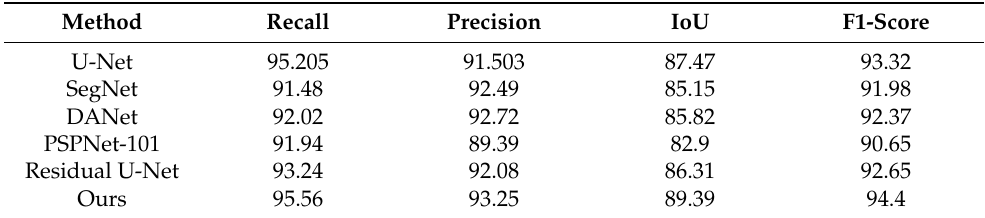
Table 6. Quantitative comparison results (%) among our method and the other five classical building extraction and segmentation methods tested on the WHU dataset.